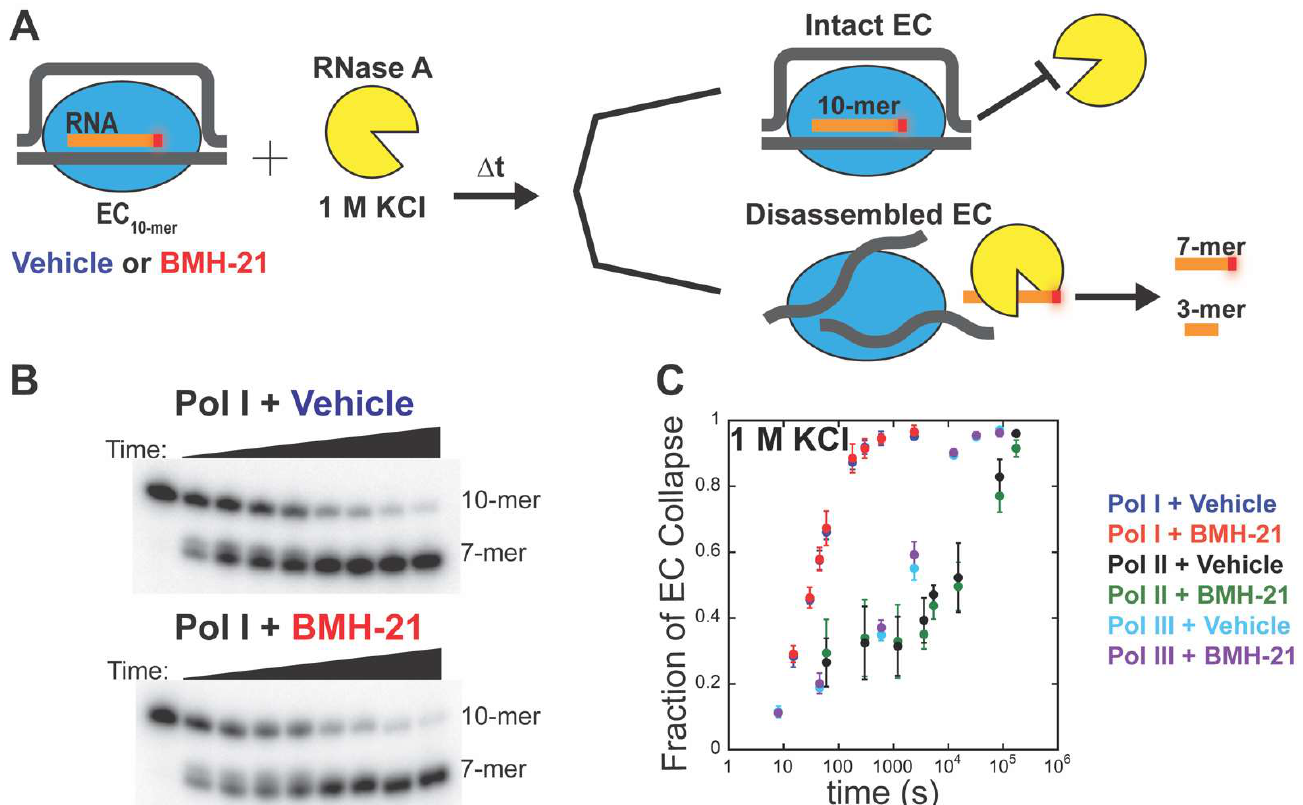
Figure 5. Pol I, II, and III EC stability in the presence of vehicle or BMH-21. ( A ) Schematic for EC stability assay. Pol I, II, or III radiolabeled ECs are mixed with vehicle or BMH-21 (1 µ M), RNase A (10 µ M), and KCl (1 M) at t = 0. Reactions were collected continuously and quenched in loading dye. Reactions were run on polyacrylamide sequencing gels to resolve the 10-mers and 7-mers that evidence intact or collapsed ECs, respectively. ( B ) Representative gels of Pol I EC stability time courses collected in the presence of vehicle, top, or BMH-21, bottom. ( C ) Plot of the fraction of EC collapse over time for each Pol in presence of vehicle and BMH-21. Time courses were collected in triplicate and the mean value is plotted with error bars corresponding to the standard deviation about the